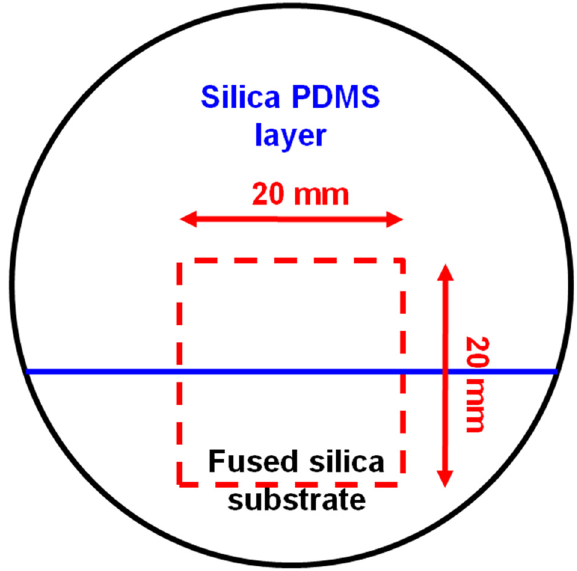
Figure 5. Scheme of the studied sample with the measurement area of 20 × 20 mm 2 approximately in the center of the film boundary sample.